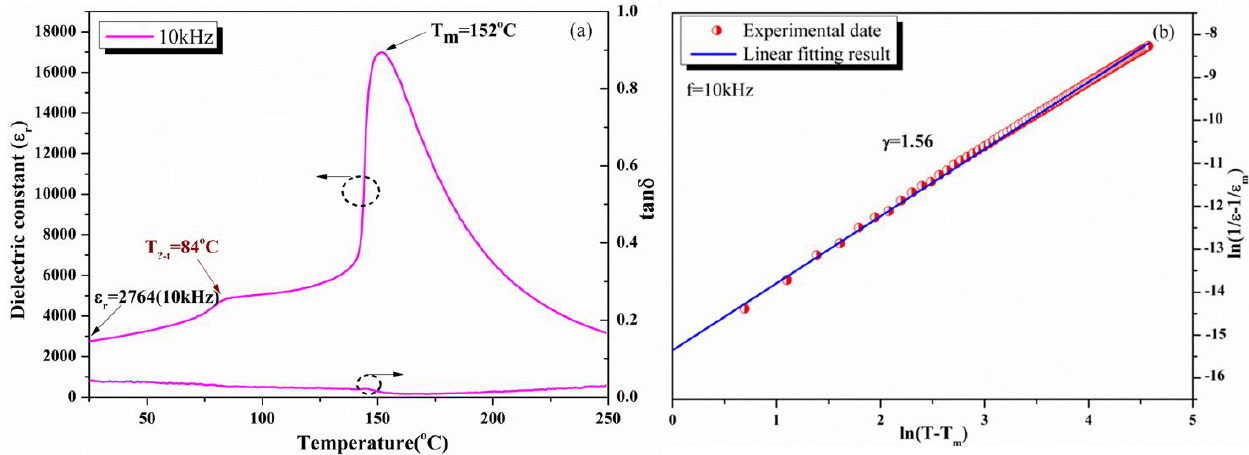
Figure 1. ( a ) Dielectric permittivity and dielectric loss for unpoled [011] single crystal at 10 kHz; ( b ) Plot of ln(1/ε crystal at 10